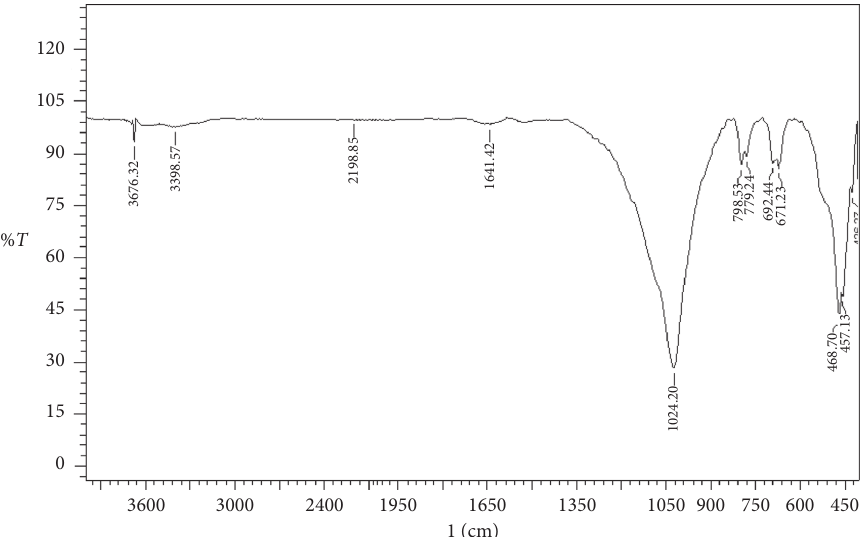
Figure 13: Infrared spectrum of the ZnO/sepiolite composite prepared by the hydrolytic precipitation